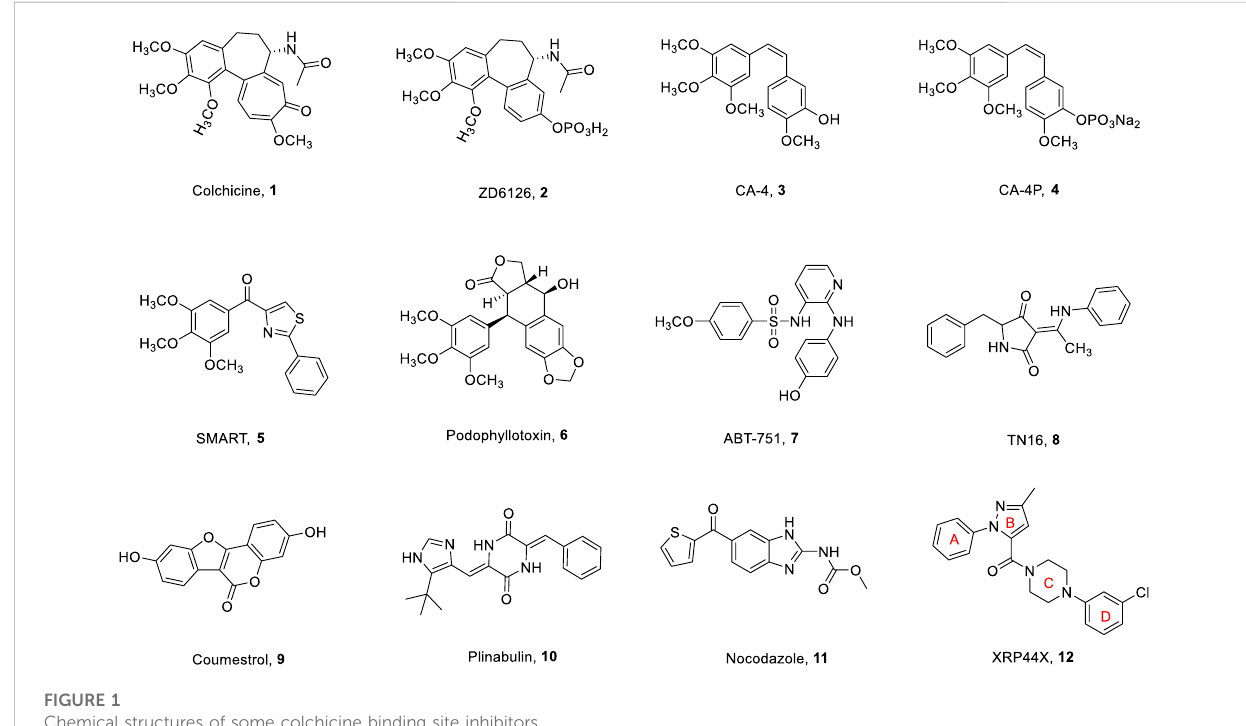
FIGURE 1 Chemical structures of some colchicine binding site